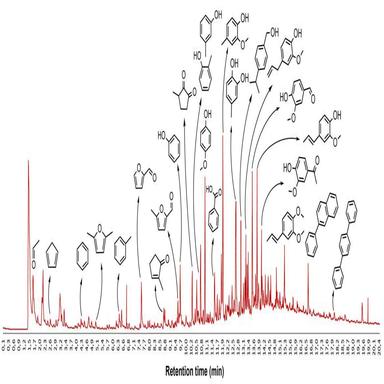
Py-GC–MS chromatogram for the PL with the main peaks identified.